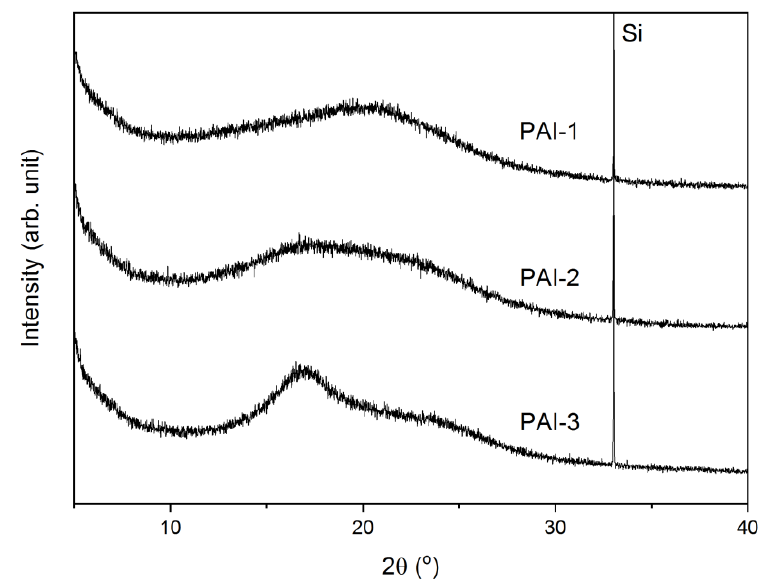
Figure 4. WAXD patterns of the PAIs.